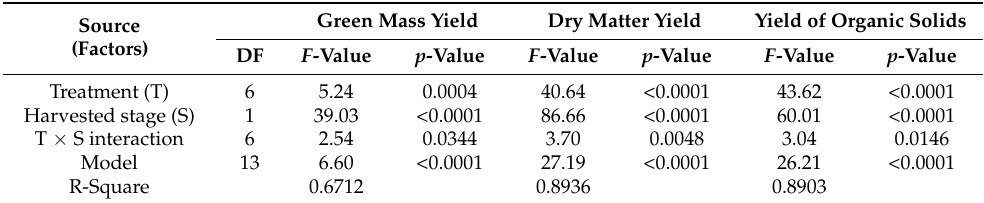
Table 4. Analysis of variance for green mass yield, dry matter yield and yield of organic solids for each experimental factor (treatment and harvested stage) and their interactions. Data included both years ( n = 8).